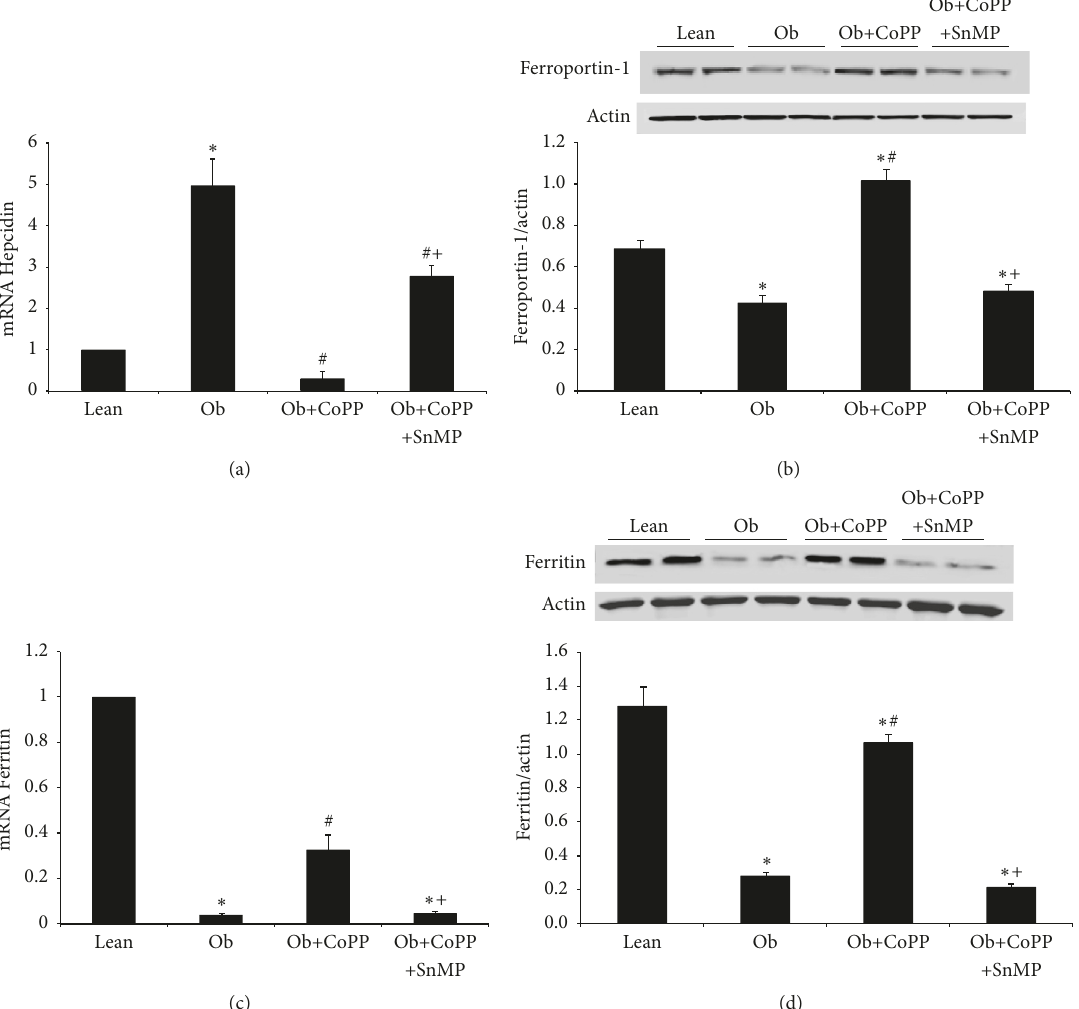
Figure 3: Effect of HO-1 induction on hepcidin, ferroportin, and ferritin levels in liver of lean and obese mice. (a) Hepcidin mRNA levels, (b) ferroportin protein levels, and ferritin mRNA and protein levels in (c) and (d), respectively. Results are mean ± SEM. 𝑛 = 3 -4, ∗ 𝑝 < 0.05 versus lean; # 𝑝 < 0.05 versus obese; + 𝑝 < 0.05 versus obese